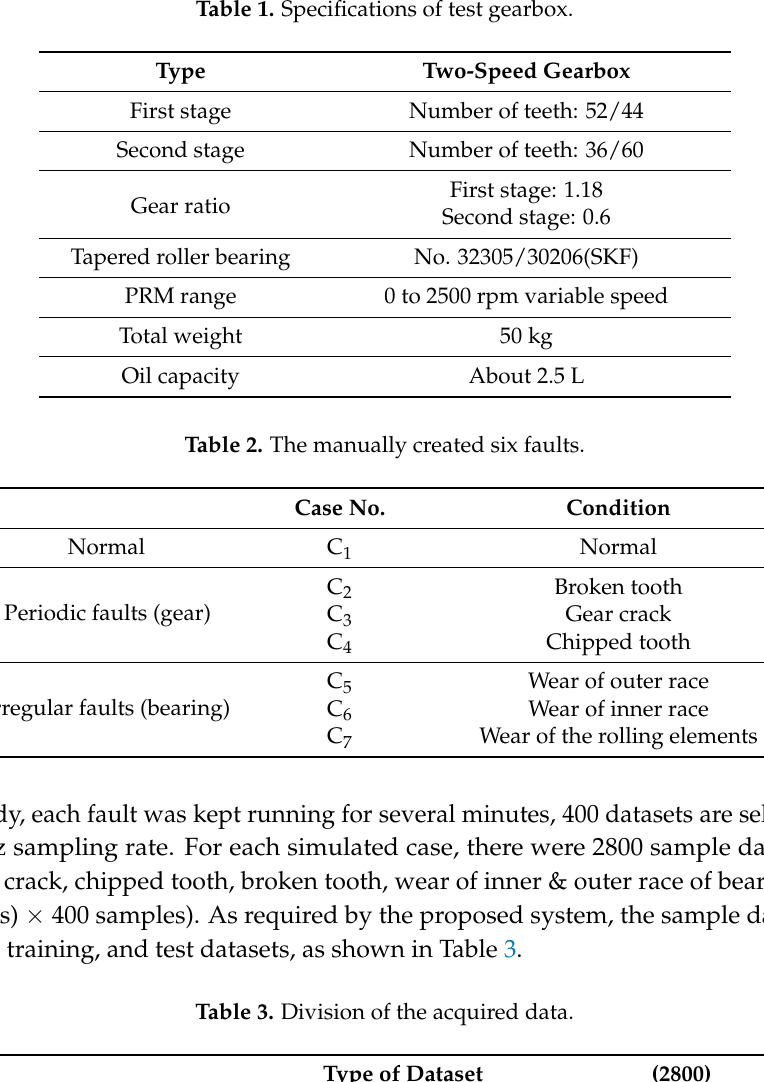
Table 1. Specifications of test gearbox.